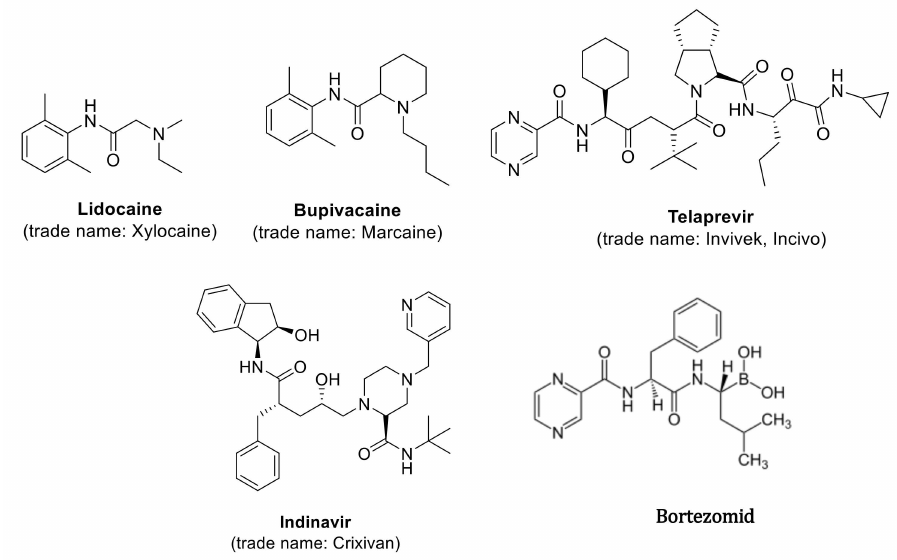
Figure 1. Examples of biologic active compound synthetized via Ugi